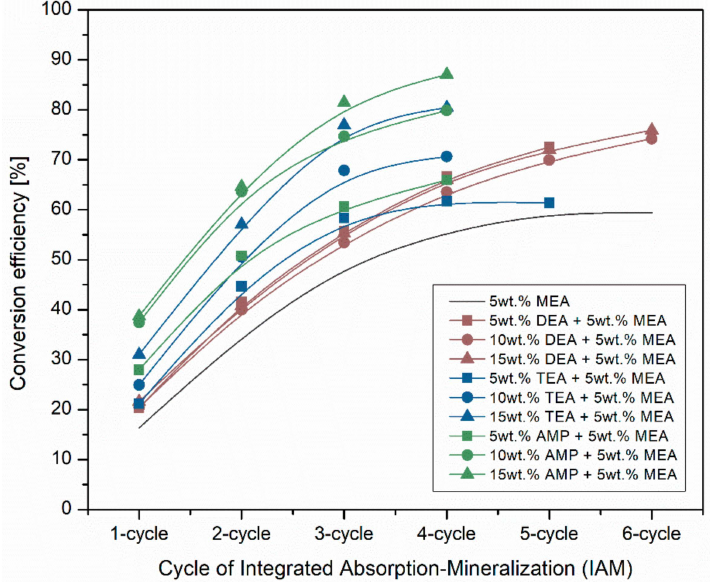
Figure 6. Conversion efficiency of blended alkanolamine absorbents in multicycle integrated absorption–mineralization